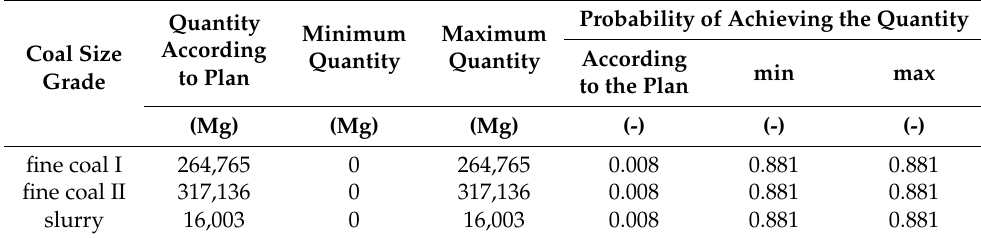
Table A10. A summary of the volumes of sales of the individual coal grades with the probability of their achievement at σ yprog for mine “A”.